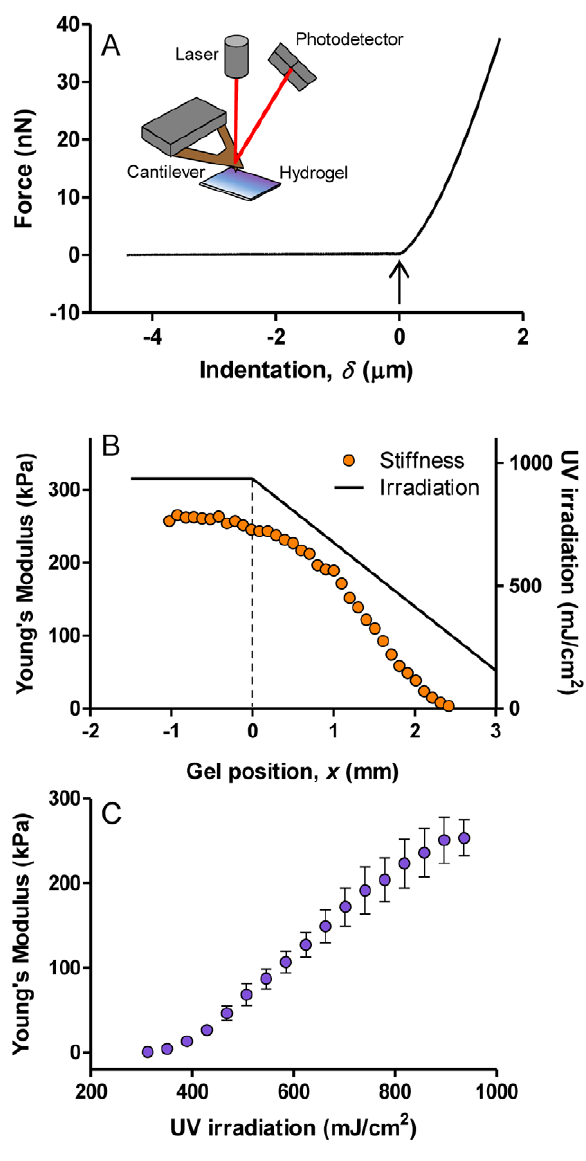
Figure 2. Characterization of the stiffness gradient hydrogels. (A) Schematic of AFM hydrogel mechanical measurement: (Cartoon) Illustration of an AFM probing the hydrogel elastic modulus; (Graph) Force–indentation ( F – d ) curve obtained as the cantilever tip ap- proached and indented a hydrogel (solid line) at 10 m m s 2 1 .This curve was used to determine the contact point between the tip and the sample (arrow). The rising portion of the curve yielded the Young’s modulus ( E ) of the hydrogel. (B) Hydrogel stiffness variation (circles) produced by a linear irradiation profile (solid line). At the beginning of the fabrication process, the opaque mask is placed at gel position x =0 mm (indicated by a dashed line). For x , 0, the hydrogel irradiation (solid line) is constant during the fabrication process. As the fabrication begins, the mask is moved at a constant speed of 15 m m s 2 1 . This results in a decreasing irradiation from the dashed line to the end of the gel. Although the irradiation has a linear profile, the Young’s modulus of this hydrogel region decreases non-linearly from 240 kPa to , 1 kPa. (C) Hydrogel stiffness as a function of irradiation dose. We use this calibration curve to compute the mask speed profile needed to linearize the gel stiffness profile (see Text S1, Fig. S2 and Fig. S3). Error bars represent SE of 4 replicates.